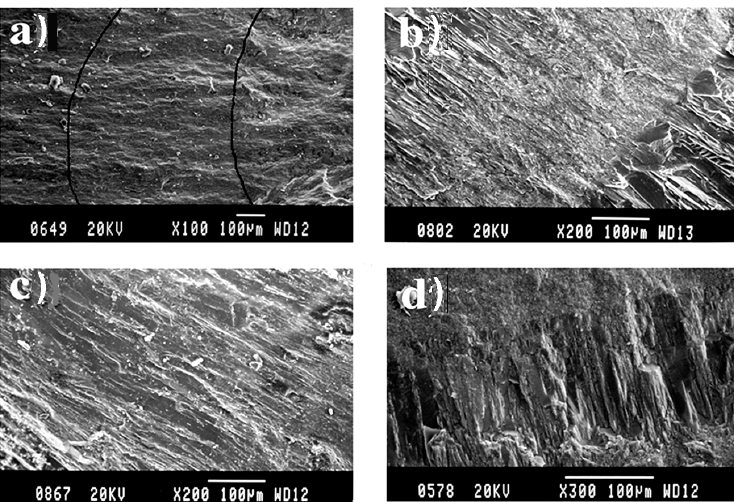
Figure 12. ( a – d ) are the white banded regions from the same agates shown in Figure 11: ( a ) Rio Grande do Sul, Brazil 135 Ma, (52 nm) 135 Ma. The black lines mark a faint white band; ( b ) Isle of Mull, Scotland, 60 Ma (72 nm); ( c ) Agate Creek, Queensland, Australia 275 Ma (74 nm); ( d ) Ethiebeaton Quarry, Scotland 412 Ma (96 nm). The stated age is the host age and crystallite size is the mean crystallite size for that particular region. The properties of the Brazilian agate, including crystallite size, indicate a formation age of ~26 Ma. SEM details as given in Figure 11.